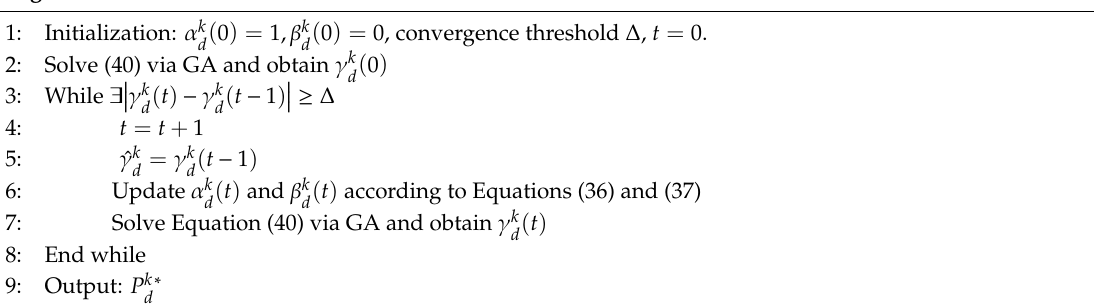
Algorithm 3 Power allocation based on SCA and GA.